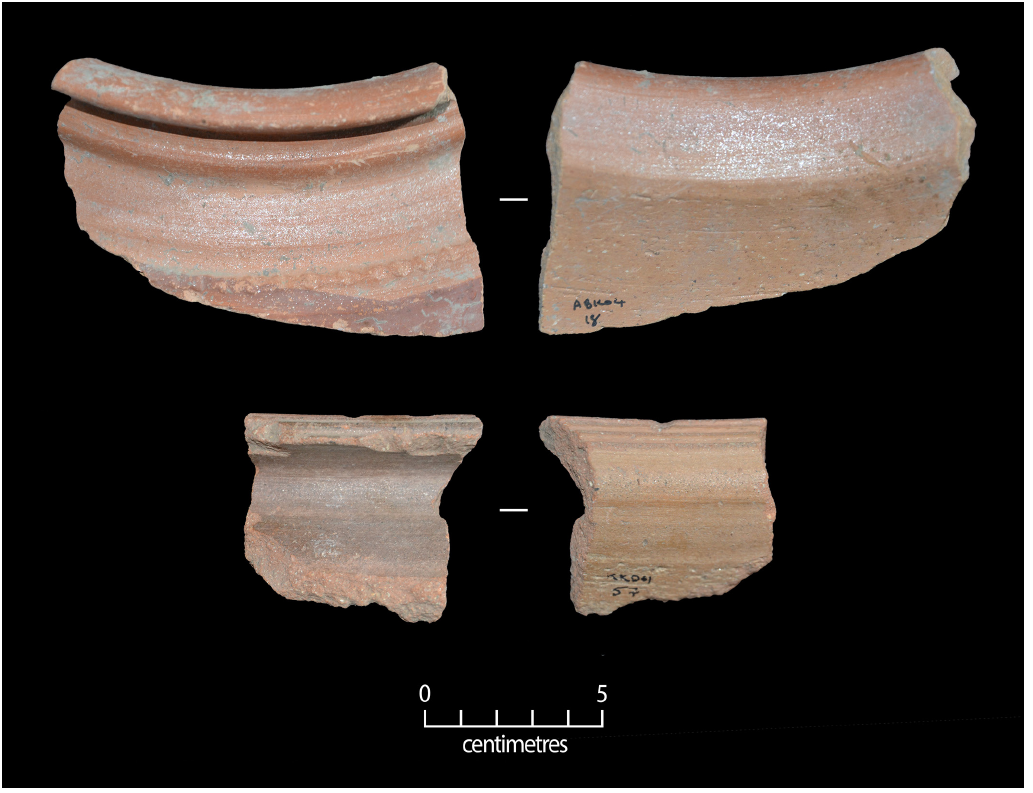
Figure 23: External surfaces of two Class 6 variant 4